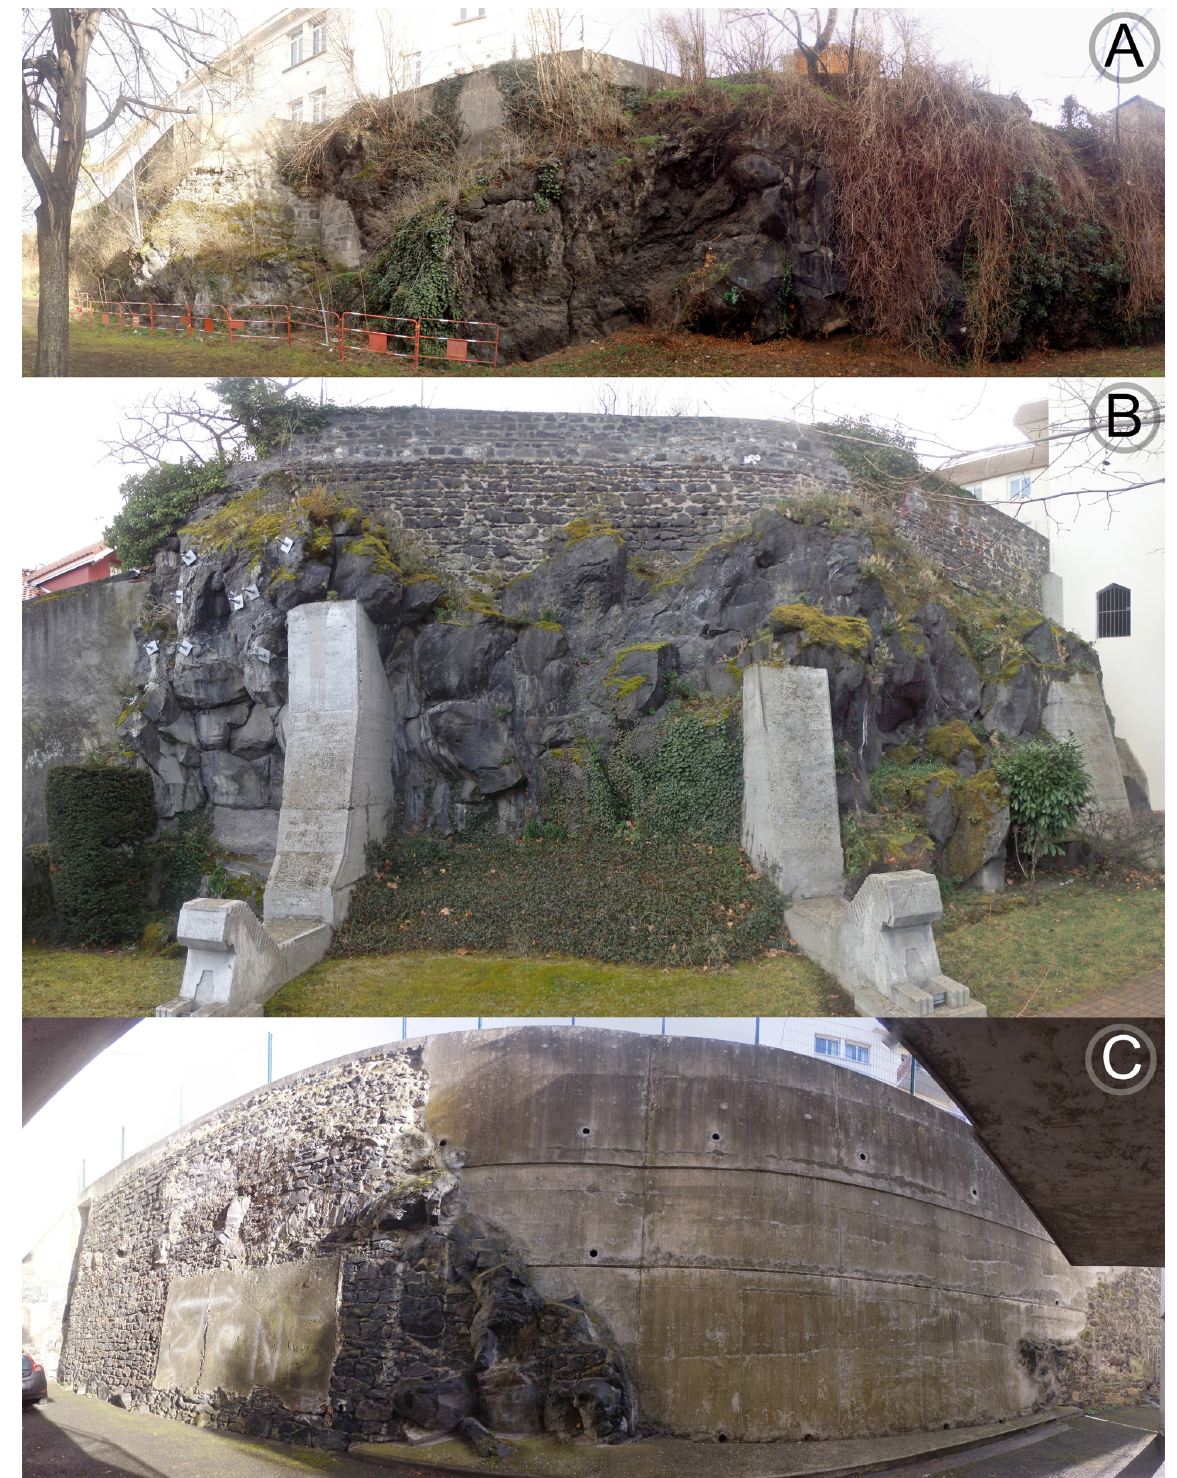
Fig. 8. Three examples of slope stabilization of outcrops of Grave Noire lava